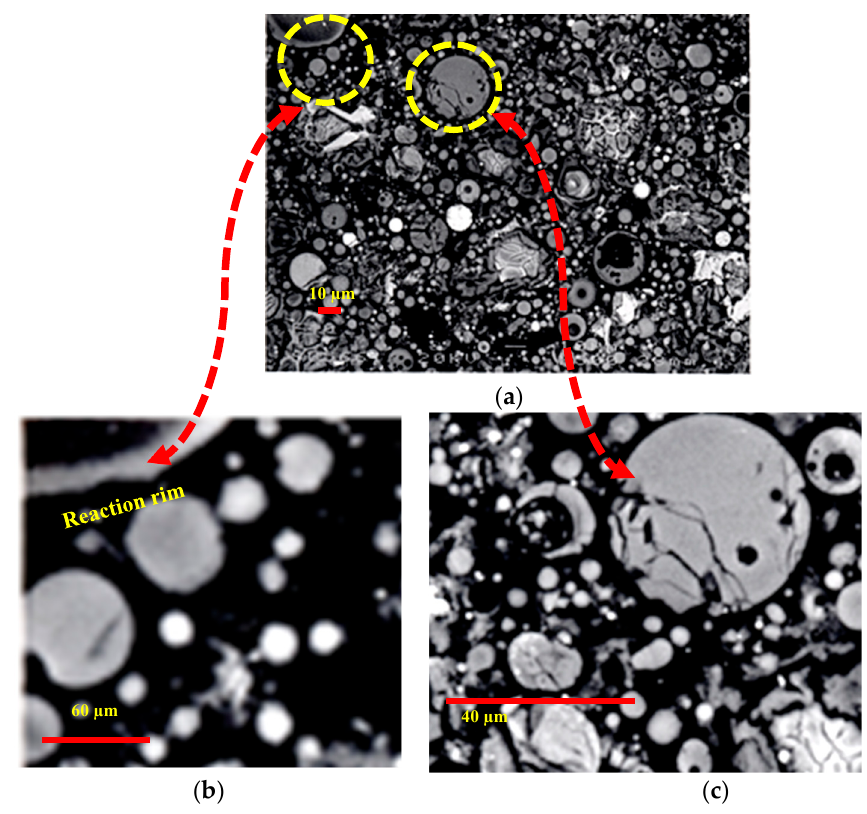
Figure 13. Binary paste mixture containing; ( a ) 40% PFA, ( b ) 6× enlarged spots reaction rims around PFa, ( c ) 4× enlarged PFa particle cracked due to pozzolanic reaction.